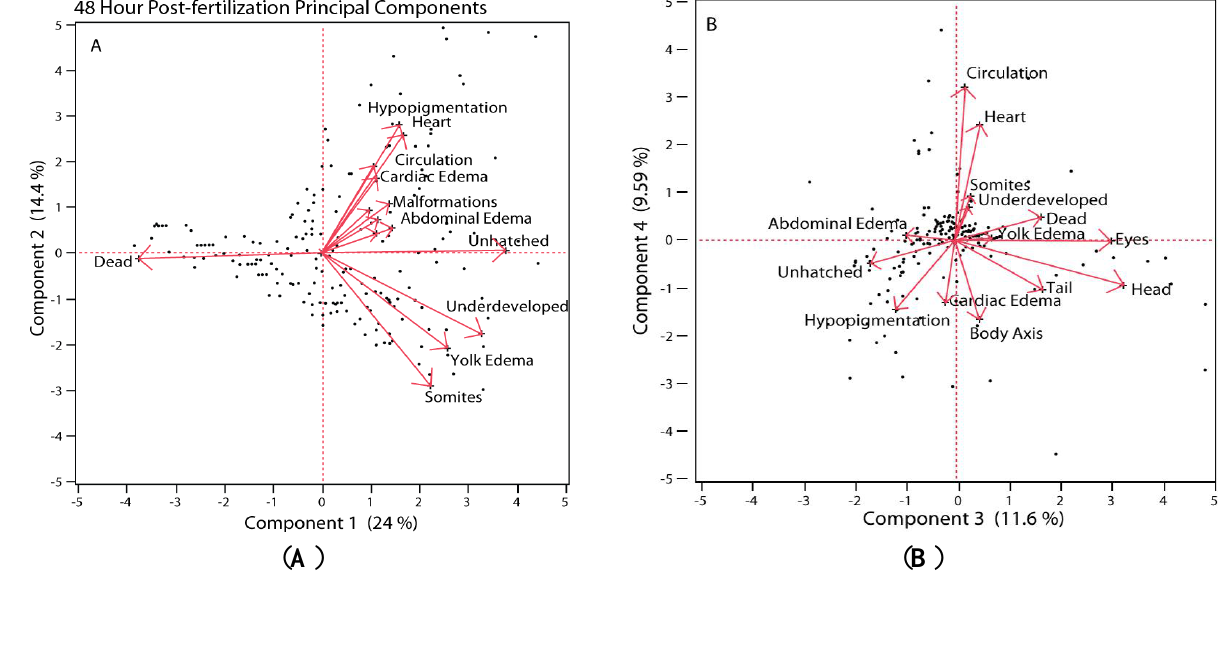
Figure 3. Scatterplots of the scores for pairs of principal components overlaid with a matrix of two-dimensional representations of factor loading of early life-stage endpoints recorded at 48 h post-fertilization. Labeled biplot rays show eigenvectors of endpoints relative to each component in multivariate space. ( A ) X-axis represents component 1 and Y-axis represents component 2. ( B ) X-axis represents component 3 and Y-axis represents component